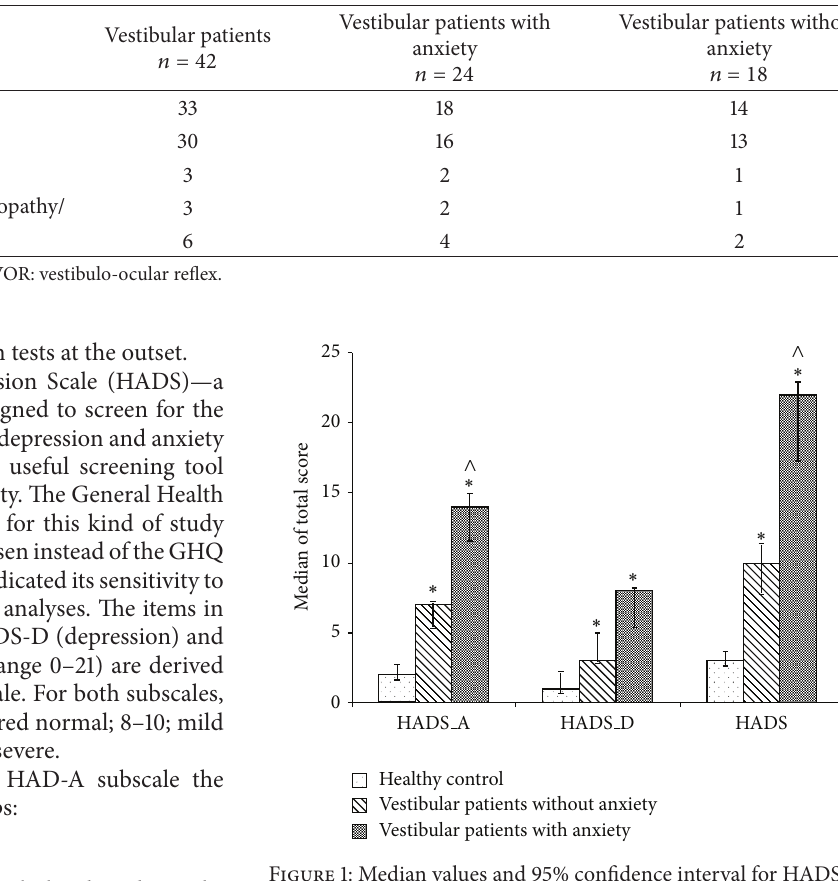
Table 2: Clinical diagnosis of the vestibular patients participating in the study.